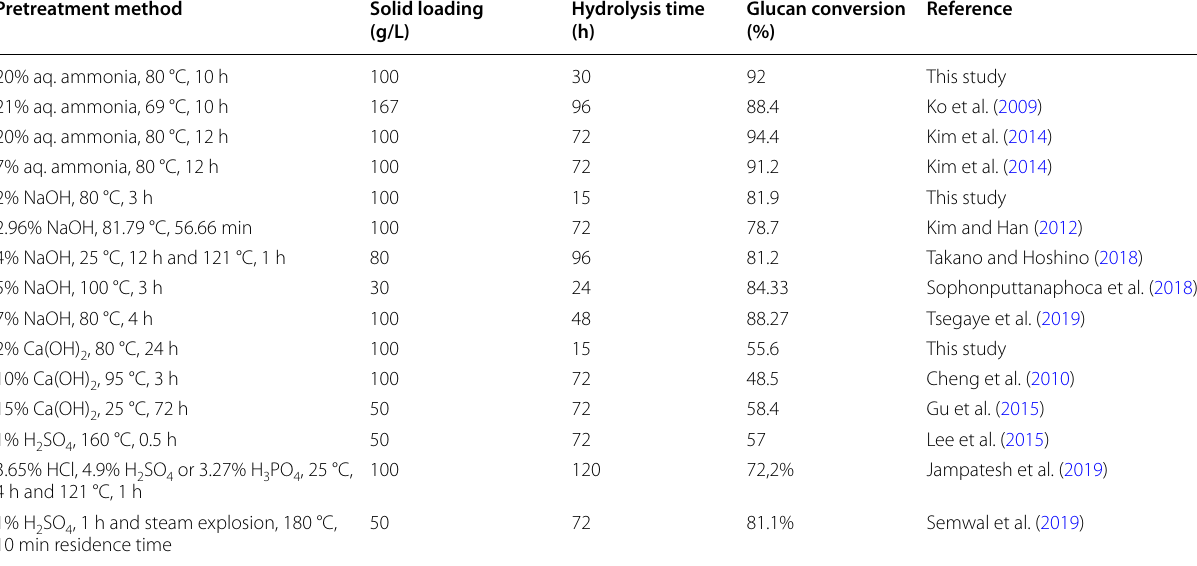
straw, the highest sugar yield of 60–66% was obtained for the samples pretreated at 30 °C for 48 h (Additional file 1: Figure S2A), or 80 °C for 24 h (Additional files 1: Figure S2B), while significantly lower yield was noted when the pretreatment was performed at 121 °C (Additional files 1: Figure S2C). Pretreatment with aqueous ammonia gave the highest sugar yield ranging between 77 and 87% upon enzymatic hydrolysis (Additional file 1: Figure S3A, B), the highest yield being obtained for the straw pretreated at 80 °C for 15 h (Additional file 1: Figure S3B). However, a much longer time (30 h) for enzymatic treatment was needed to obtain the maximal sugar release as compared Table 2 Comparison of the glucan‑to‑glucose conversion of cellulose in rice straw treated with different pretreatment methods followed by enzymatic hydrolysis Pretreatment method Solid loading Hydrolysis time Glucan conversion (g/L) (h) (%)